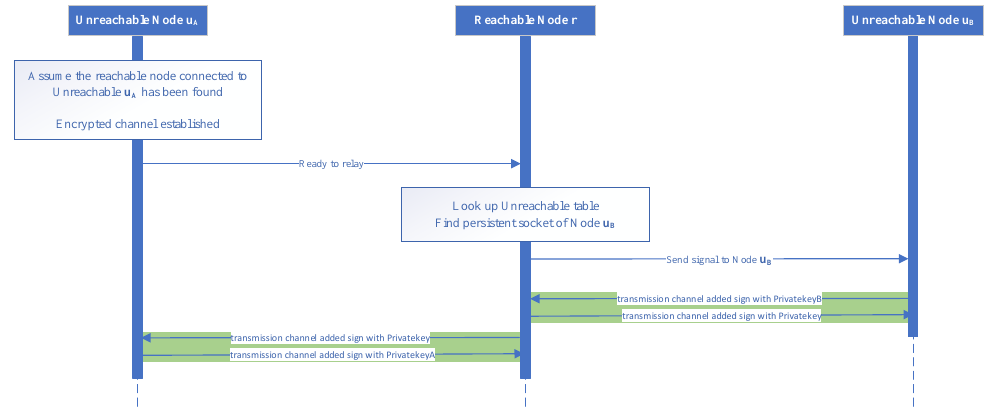
Figure 14. Flow chart of unreachable nodes u A and u B establishing data transmission channels via reachable node r